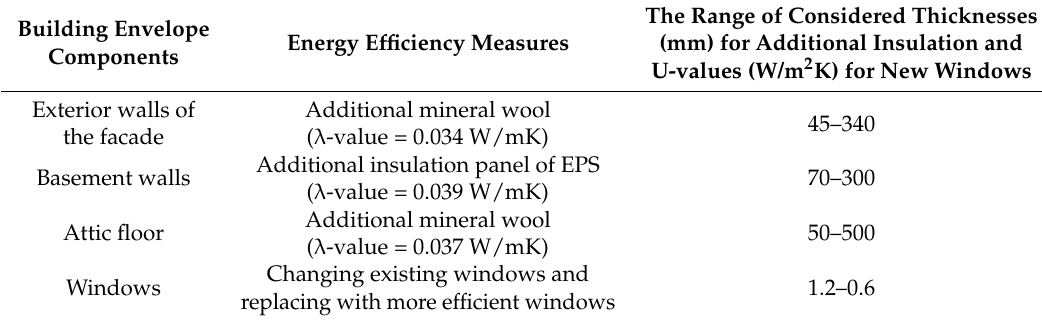
Table 6. Energy efficiency measures for building energy